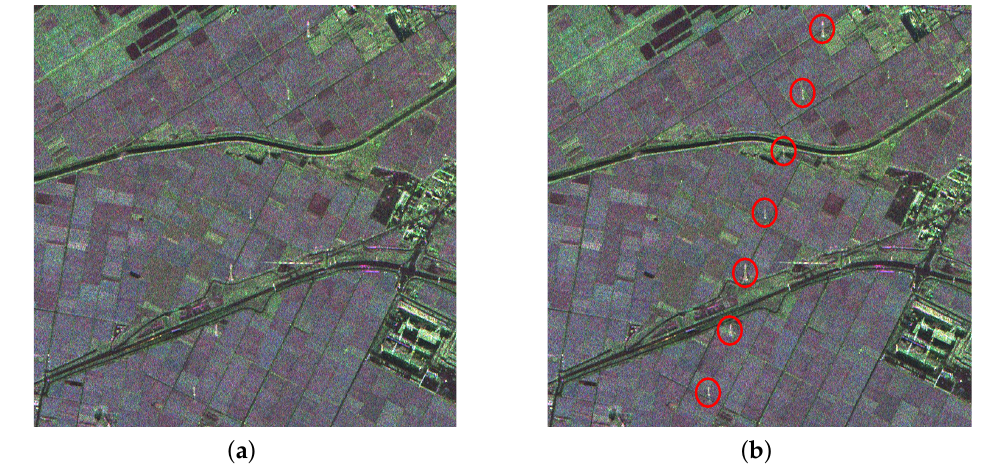
Figure 10. Pauli color coded image of Niigata Site Area. ( a ) original PolSAR image; and ( b ) marked image.